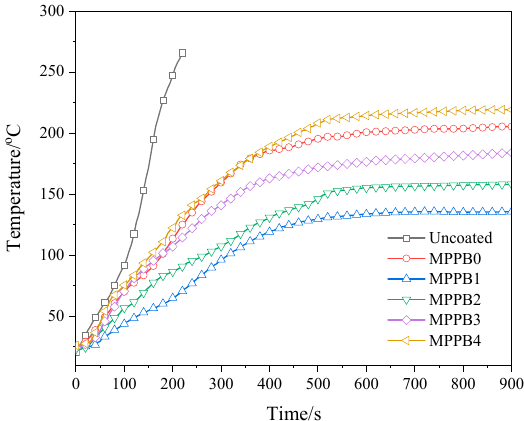
Figure 5. TG ( a ) and DTG ( b ) curves of the transparent fire-retardant coatings under nitrogen atmosphere.